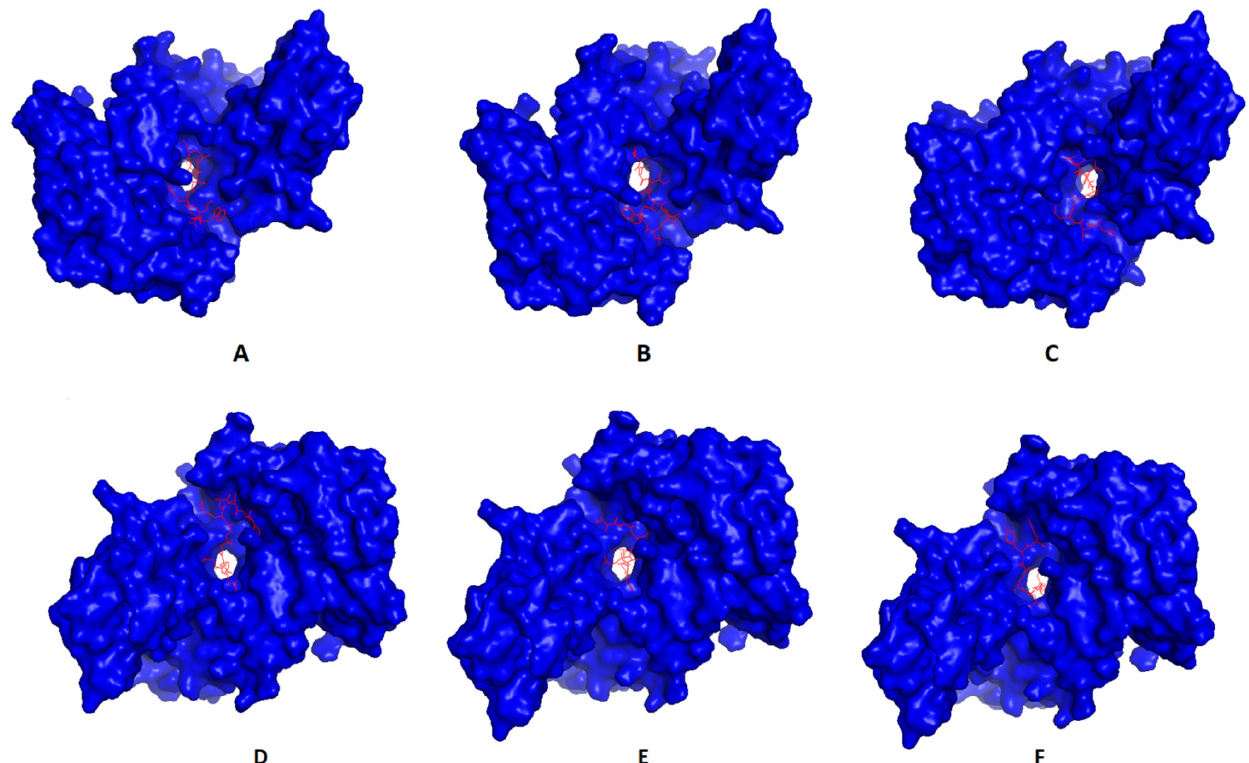
Figure 3. Predicted positions of MHC-I peptides (red color) in the 3D structure of HLA-A*11:01 receptor (blue color), structures ( A – F ) are for epitopes number 1,2,3,4,5, and 6, respectively, from Table 5.